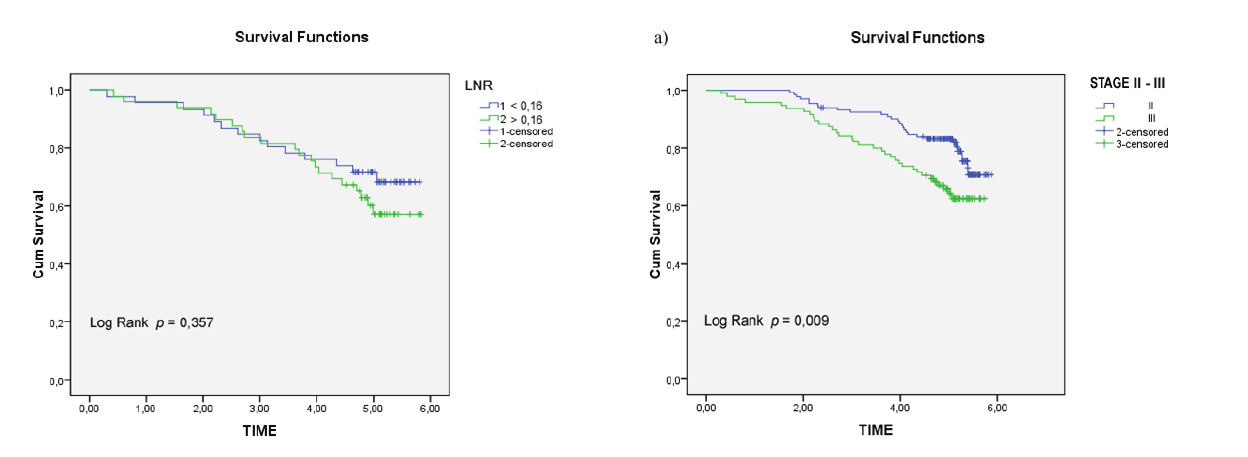
Figure 3: Overall survival (OS) according to lymph node ratio (LNR) (<0.16 vs ≥ 0.16, p =